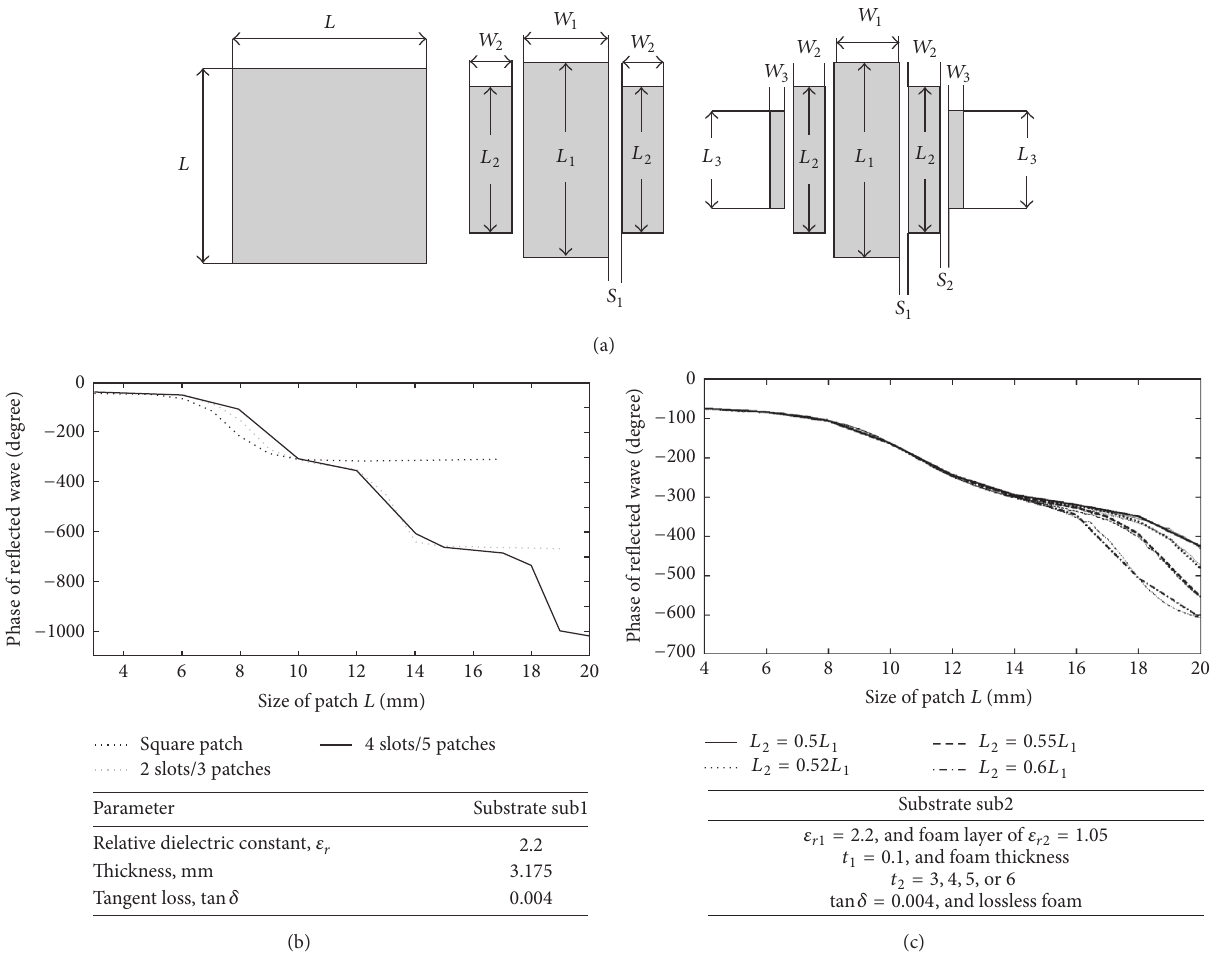
Figure 3: (a) Multislice fractal square patch; (b) simulated phase response versus patch size of square patch and multislice fractals with two- slots and four-slots ( 𝑓 0 = 10 GHz); (c) linearized phase responses of two-slots multislice fractal for different patches lengths (foam substrate layer thickness = 5